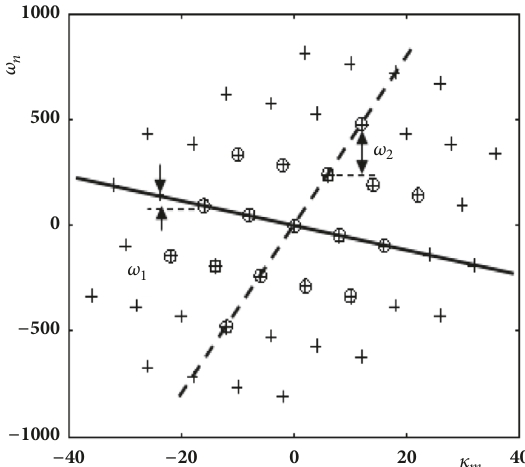
Figure 17: Counterpart of Figure 15 𝑅 = 1.1 ⋅ 10 6 .